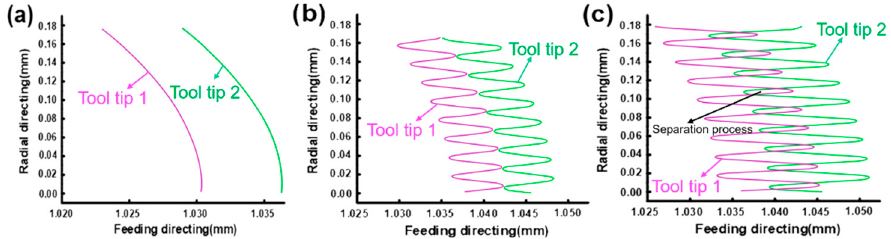
Figure 5. Simulation of tool tip trajectory ( a ): ƒ z = 6 μ m/z, A = 0 μ m; ( b ): ƒ z = 6 μ m/z, A = 3 μ m; and ( c ) ƒ z = 6 µ m/z, A = 6 µ ( c ): ƒ z = 6 μ m/z, A = 6 μ m.